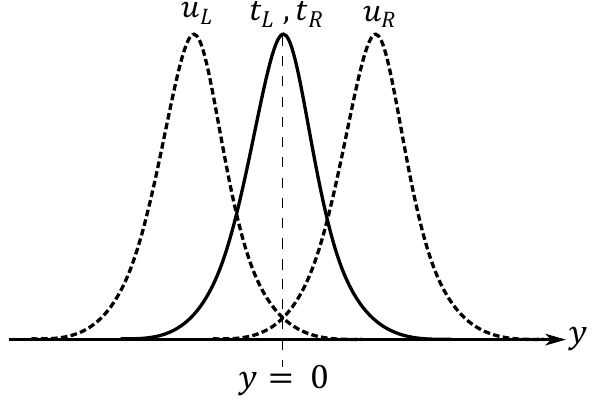
Figure 1 . The up quark components u L and u R are separated by some distance along the 5th dimension, while t L and t R are localized at the same location. A small overlap between the chiral fermions results in an exponentially suppressed e(cid:11)ective Yukawa